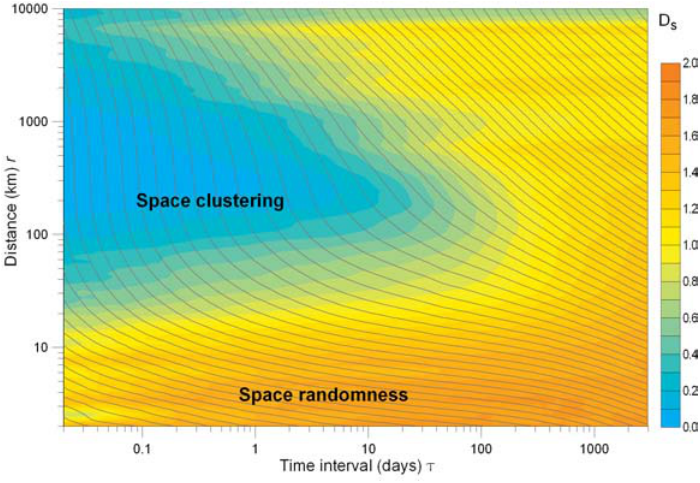
Fig. 4. Space-time combined correlation integral C c ( r , τ ) (dark contour lines) and space correlation dimension D s (coloured shaded contour) for the catalogue of global seismicity.